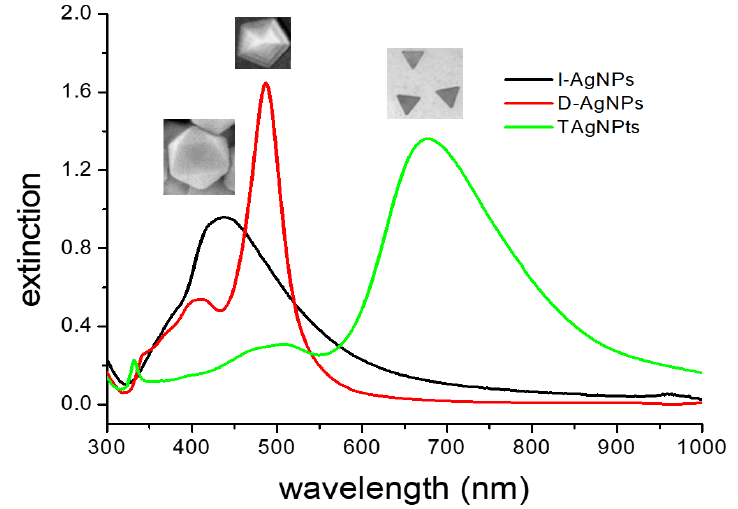
Figure 9. The extinction spectra and the morphologies of I-AgNP, D-AgNP, and TAgNPt colloids.